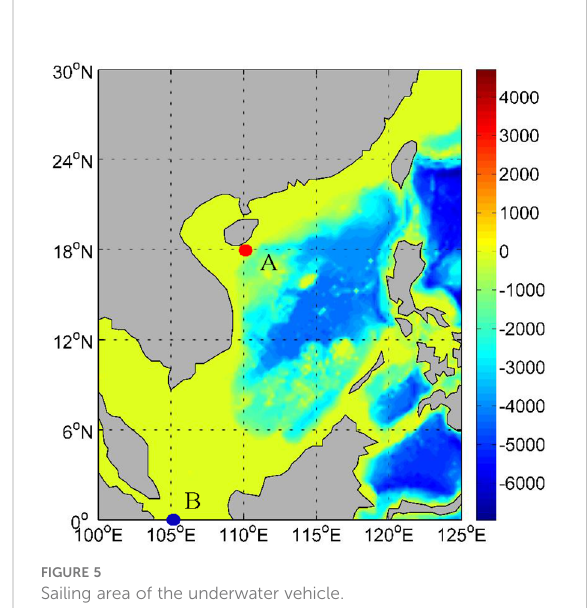
FIGURE 5 Sailing area of the underwater vehicle.